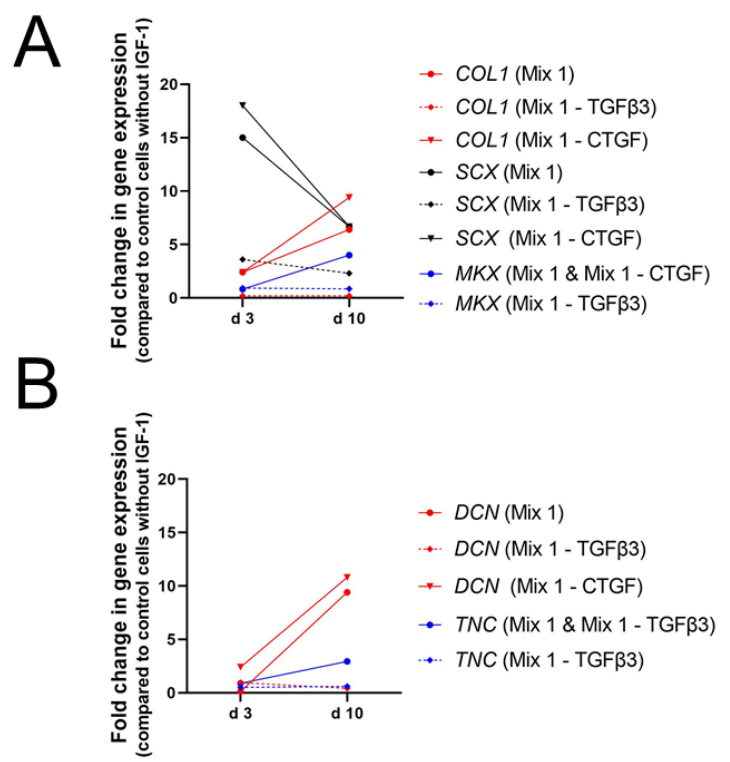
Figure 10. Impact of tenogenic induction media on the gene expression of human tenocytes. Gene expression of COL1, SCX and MKX (A) and DNC and TNC (B) are given in fold changes. Key: Mix 1 contains IGF-1 (50 ng/mL), BMP-12 (50 ng/mL), CTGF (100 ng/mL), bFGF (5 ng/mL), TGF β 3 (20 ng/mL), AA (25 µg/mL), and 1% FBS